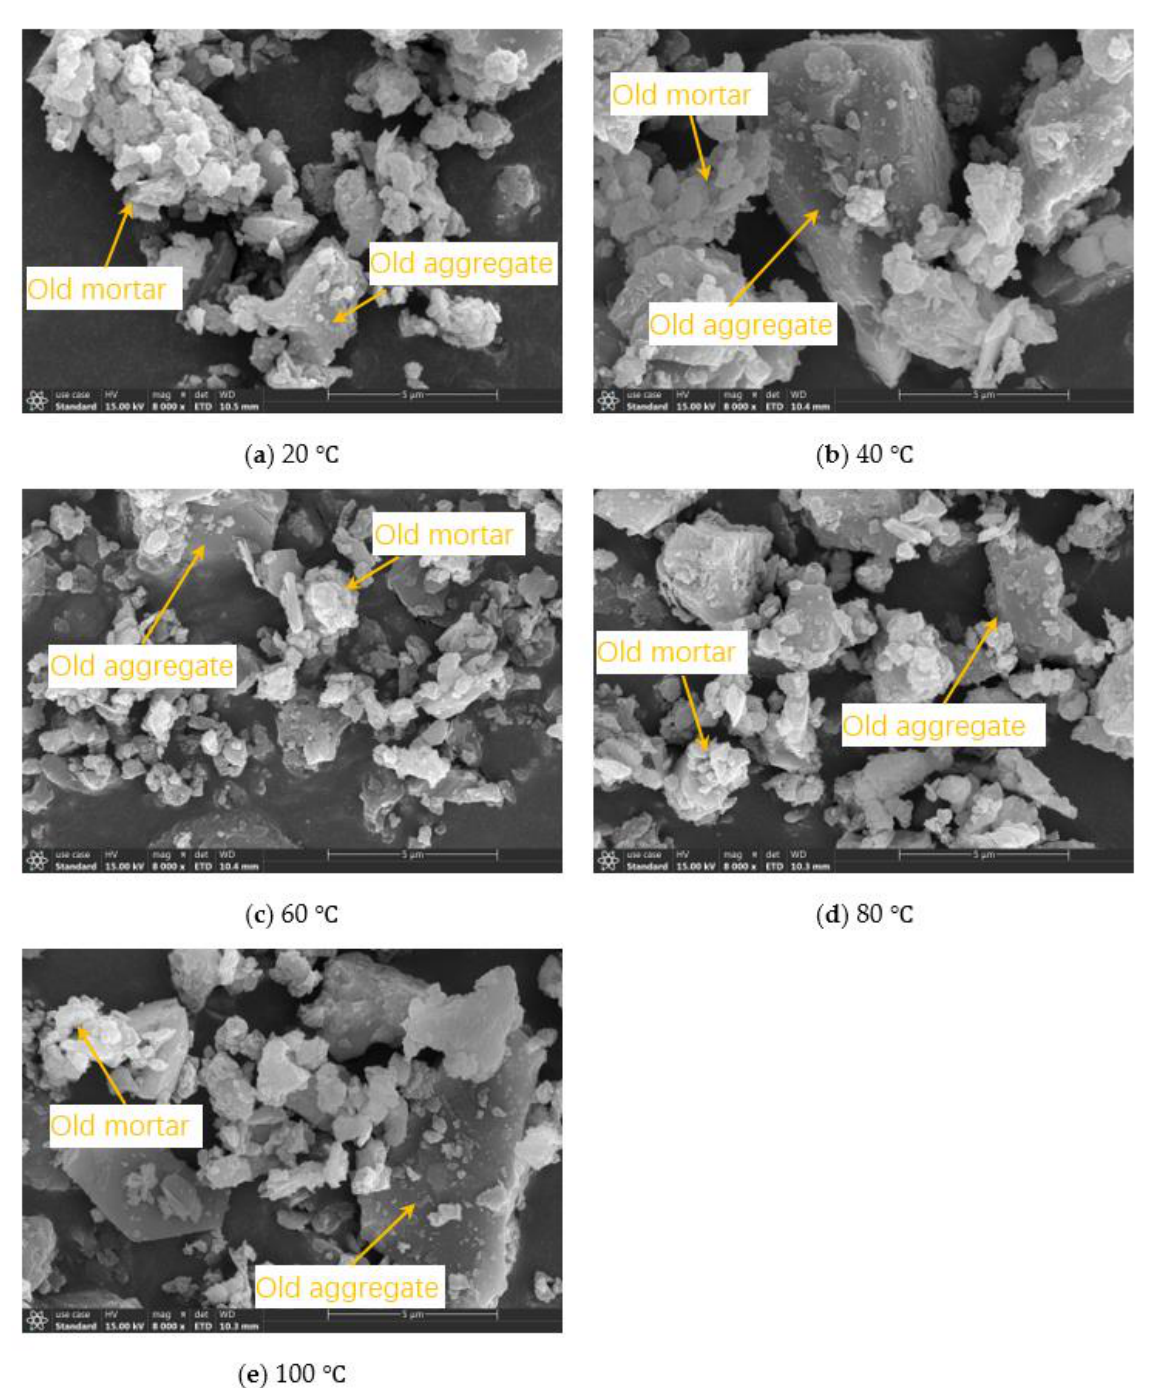
Figure 5. Micromorphology of CDWC after different pretreatment temperatures. Figure 6. It can be found that after high-temperature pretreatment, the main phases of CDWC are almost unchanged, mainly quartz, calcite, zeolite and mullite. Their main chemical components are silicon dioxide, calcium carbonate and aluminosilicate. High temperature does not destroy the phase of CDWC to form a new phase, which indicates that CDWC can undergo high-temperature